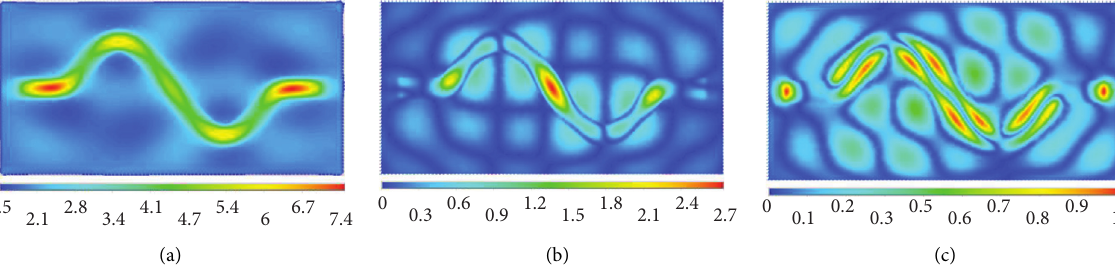
Figure 34: SV wave incident ( H � 175m, f � 1.5Hz, C